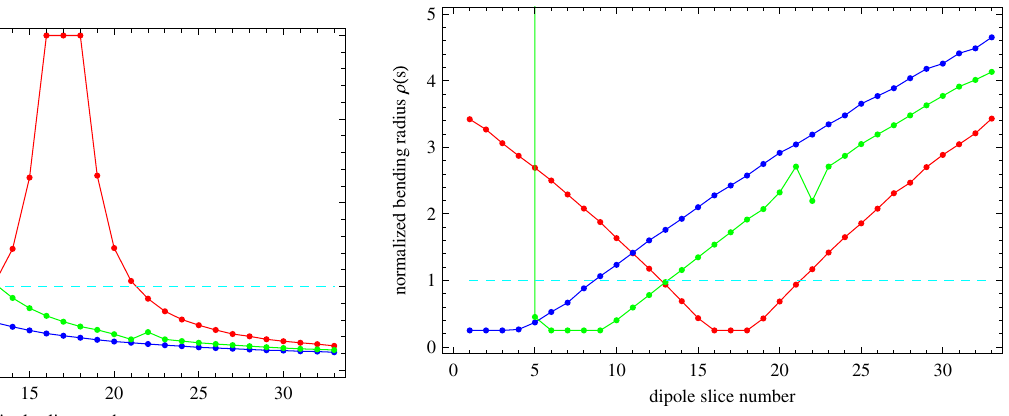
FIG. 4. Optimal bending field profiles for minimal AME (blue), TME (red), and EME (green) at maximum field strength 4 times higher than the reference dipole (dash).